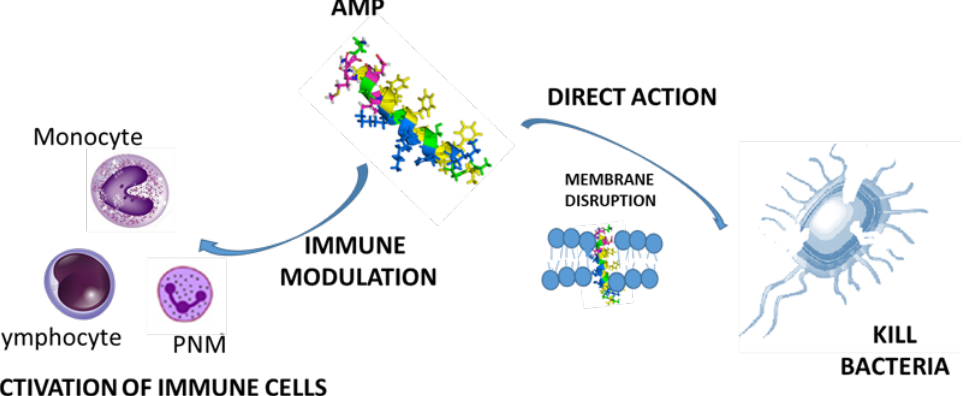
Figure 1. Antimicrobial peptides’ (AMPs) mechanism of action.